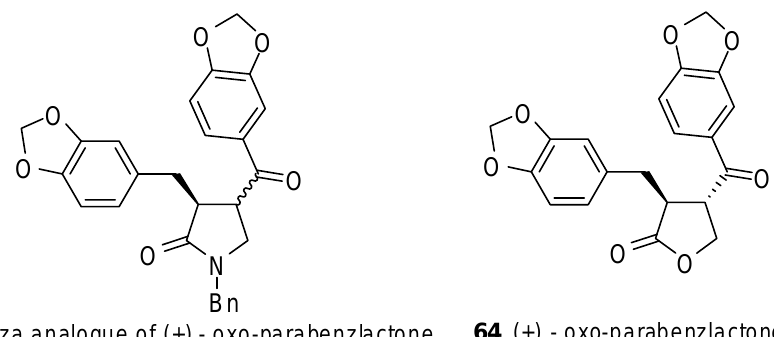
Figure 1. Aza analogue of